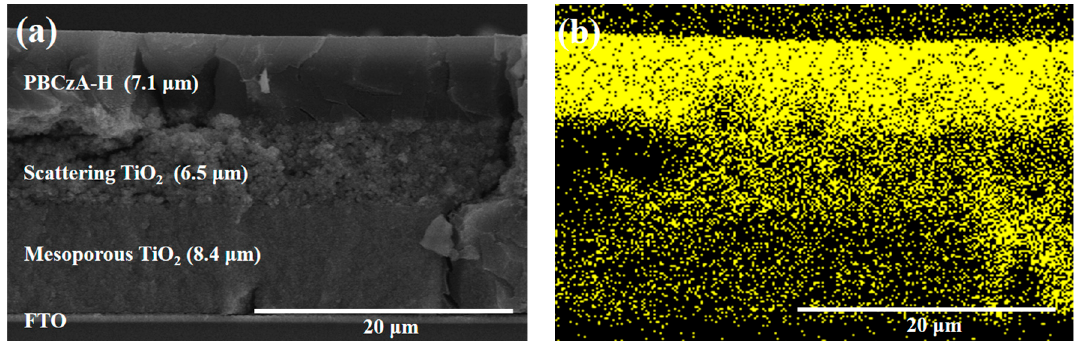
Figure 4. Cross-sectional SEM image ( a ) and EDS mapping ( b ) showing the distribution of carbon in a decapped ssDSC with PBCzA-H (without additives).